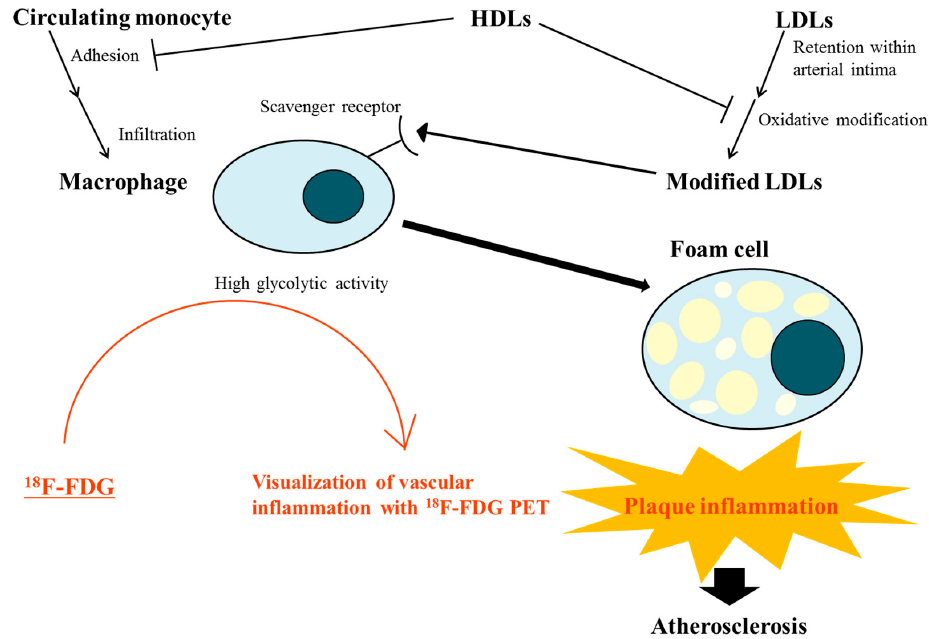
Figure 1. Interplay of lipoproteins and macrophages linked to plaque inflammation during atherosclerotic process and evaluation of this vascular inflammation by 18 F-fluorodeoxyglucose (FDG) positron emission tomography (PET). Modified low-density lipoproteins (LDLs) trigger plaque inflammation by interacting with macrophages. The macrophages ingest modified LDL through scavenger receptors and evolve into foam cells, which play a key role in the development and progression of atherosclerosis. High-density lipoproteins (HDLs) protect LDLs from oxidative modification and inhibit monocyte adhesion to the endothelium by decreasing the expression of adhesion molecules in endothelial cells. Loss of this protective function of HDL in dyslipidemic states may accelerate plaque inflammation, amplifying the role of modified LDLs. The high glycolytic activity of infiltrated macrophages enables visualization of vascular inflammation in atherosclerotic lesions by 18 F-FDG